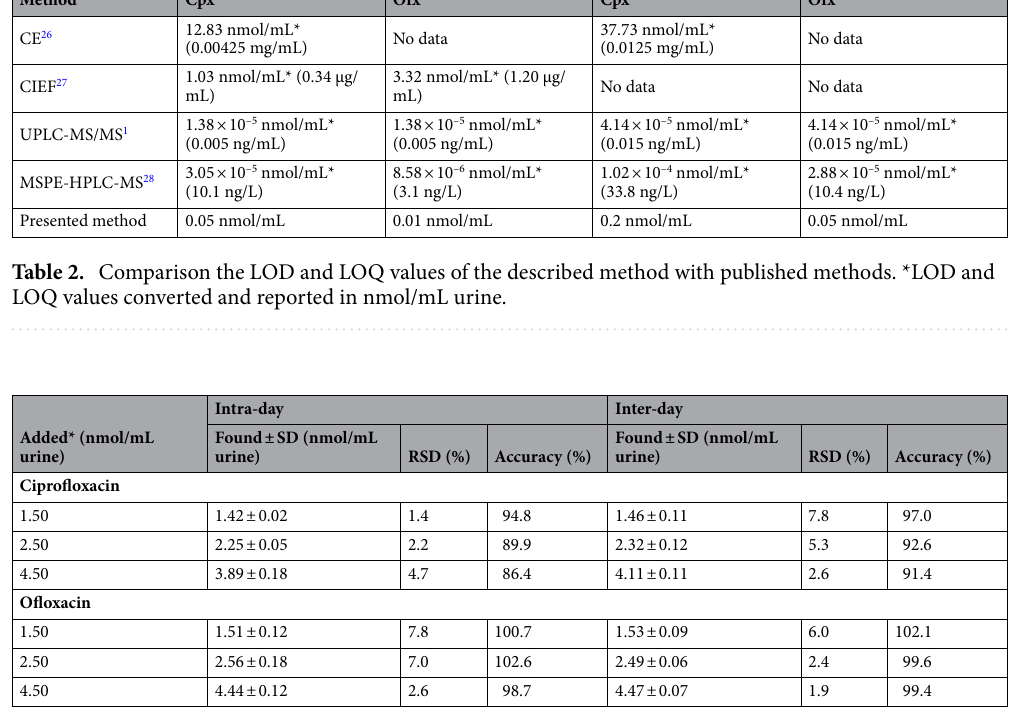
Table 3. Validation data—results. *n =